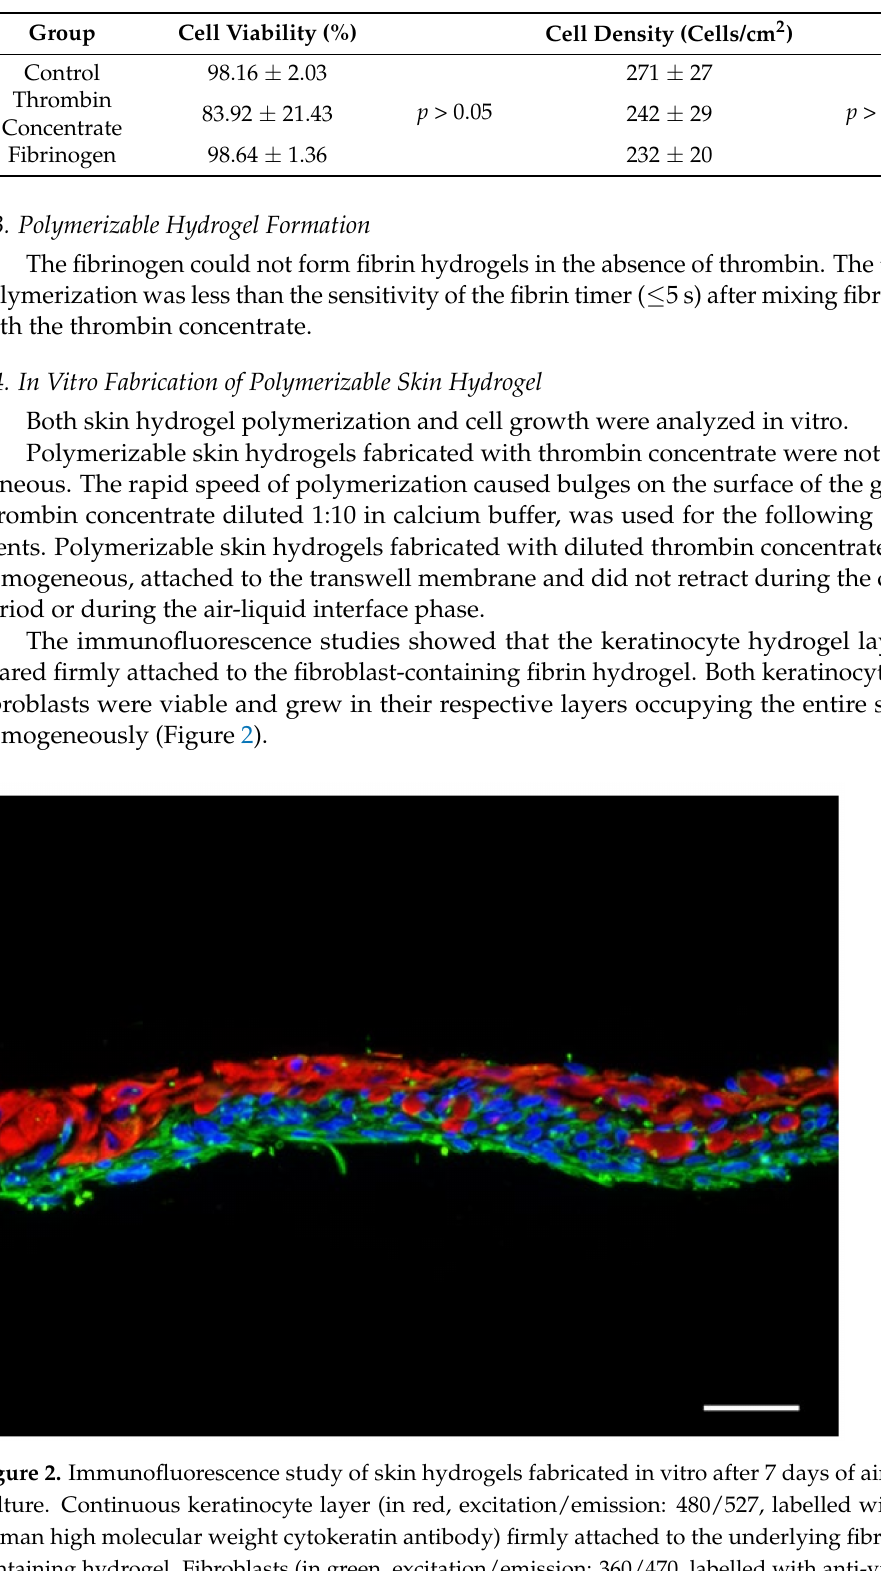
Table 1. Viability assay. Fibroblasts viability and cell density after being cultured in the presence of thrombin concentrate and fibrinogen. Samples prepared from FFPs did not show toxicity in fibroblasts since the number of cells per cm 2 and the cell viability did not decrease significatively.